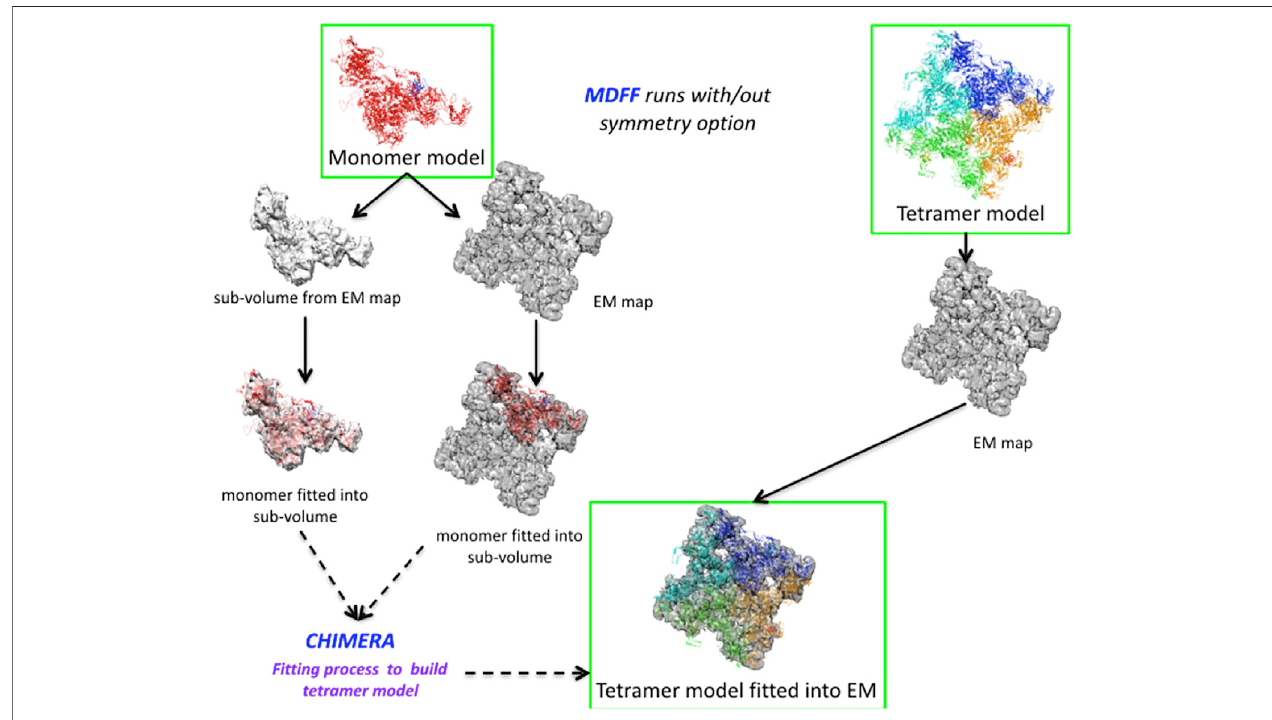
FIGURE 3 | Runs performed to produce the MDFF calculations. Two different con fi gurations are described in the Figure, either by fi tting the monomer model to a partial volume or by fi tting the tetramer model to the entire density map. The MDFF runs outlined with green rectangles represent a good compromise between the fi t achieved and time to solution (left path) or a more direct, but computationally intensive way (right path) to obtain a tetramer model fi tted to experimental maps.